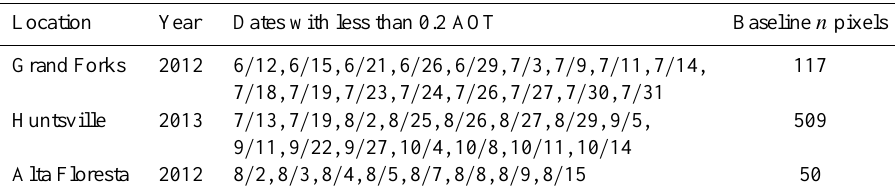
Table 4. Dates with HSRL (for Huntsville) or straddling daytime-averaged AERONET (Grand Forks and Alta Floresta) τ less than 0.2, which are used for the computations shown in Fig. 9, and the baseline (i.e., used in the actual τ retrieval) n pixels used for Grand Forks, Huntsville, and Alta Floresta. Date format: month/day.